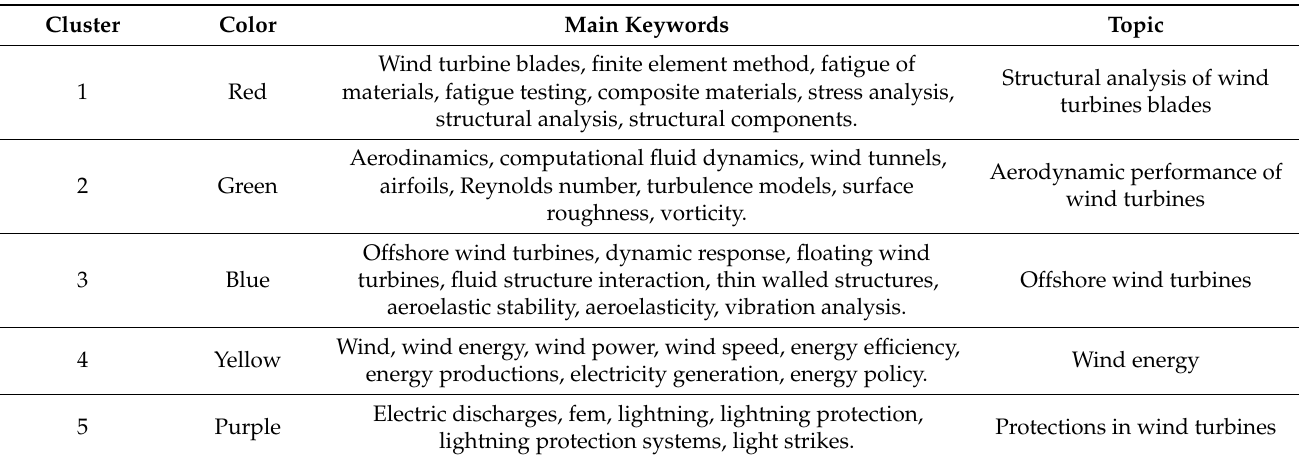
Table 1. Main clusters obtained in the co-words analysis on the topic of wind turbine efficiency.